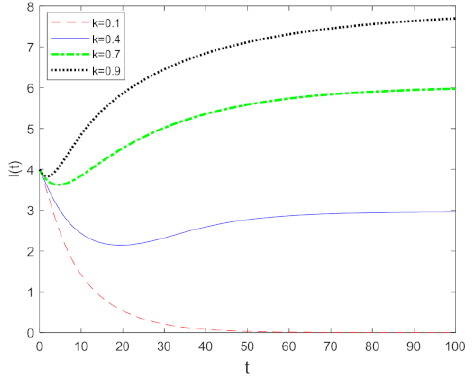
Figure 7. Trends in the number of the rumor spreading with different k